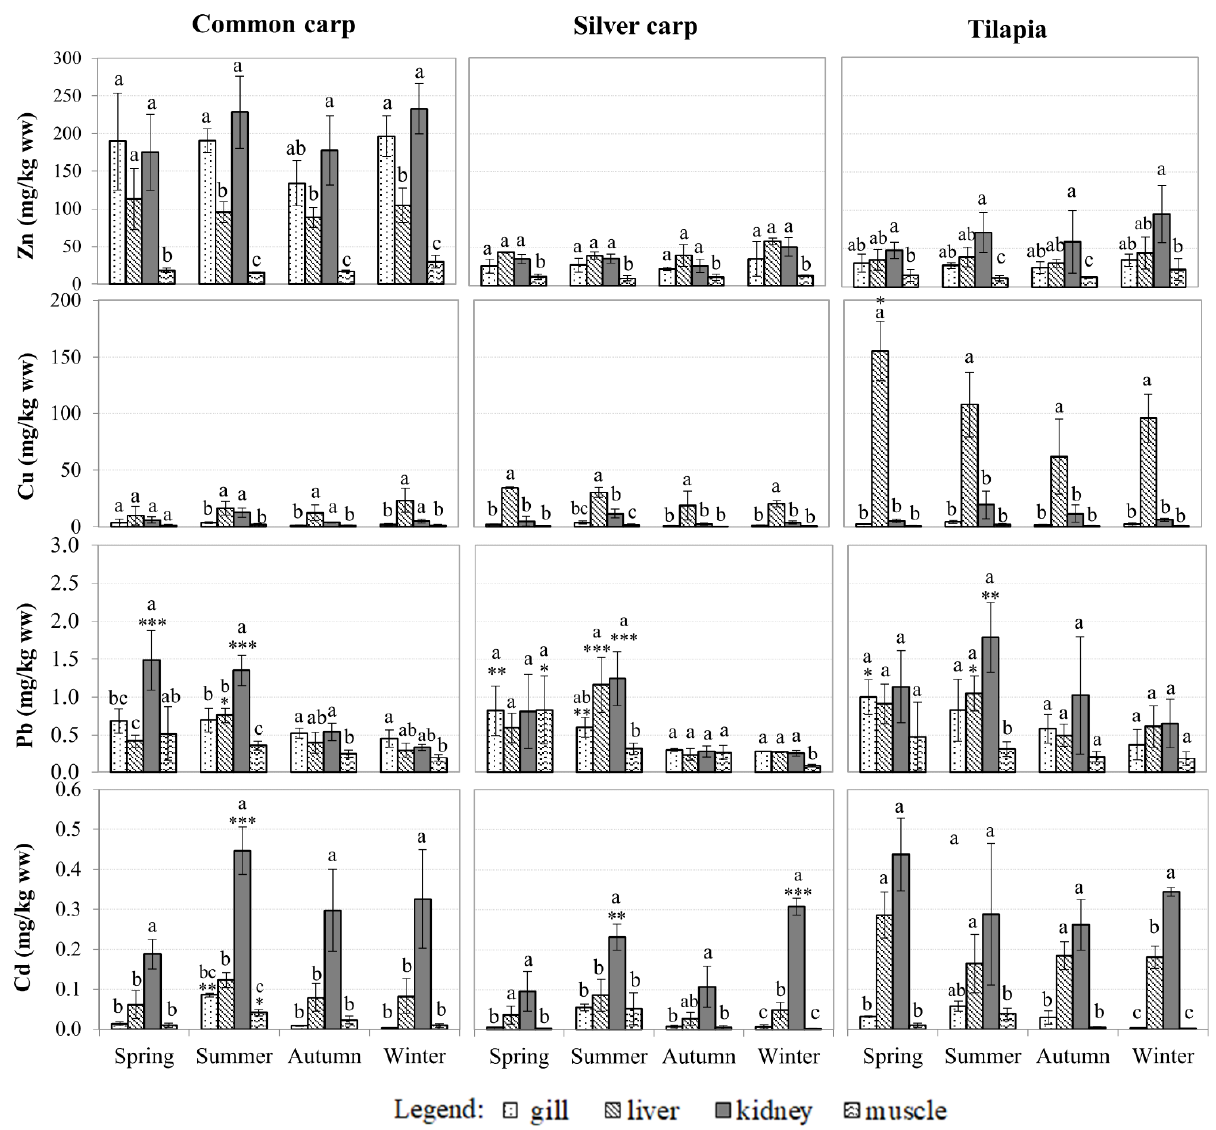
Figure 3. Concentrations of Zn, Cu, Pb, and Cd in various fish tissues (mg/kg ww) collected during different seasons. Asterisks (*) indicate statistically significant differences between seasons when compared to the lowest value in each organ (mean ± SE, n = 5–20, * p < 0.05, ** p < 0.01, *** p < 0.001). Different letters (a > b > c) denote statistically significant differences in metal levels between organs in each season ( p < 0.05; ANOVA followed by Tukey–Kramer test).